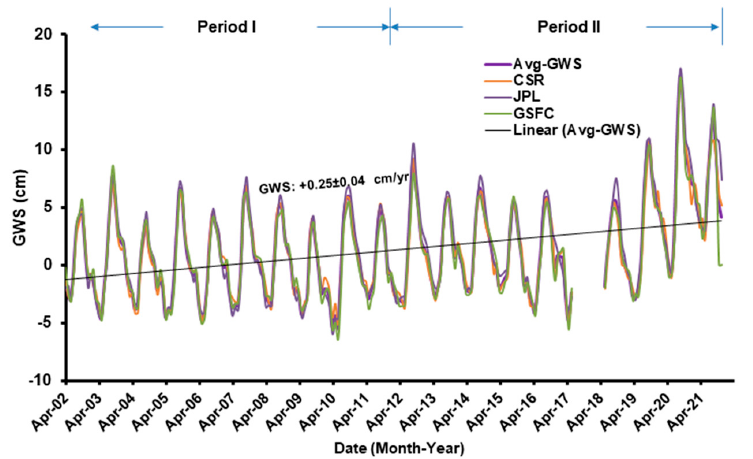
Figure 10. Monthly time series of the ∆ GWS and their mean (Avg-GWS) using the three mascon solutions over Chad.